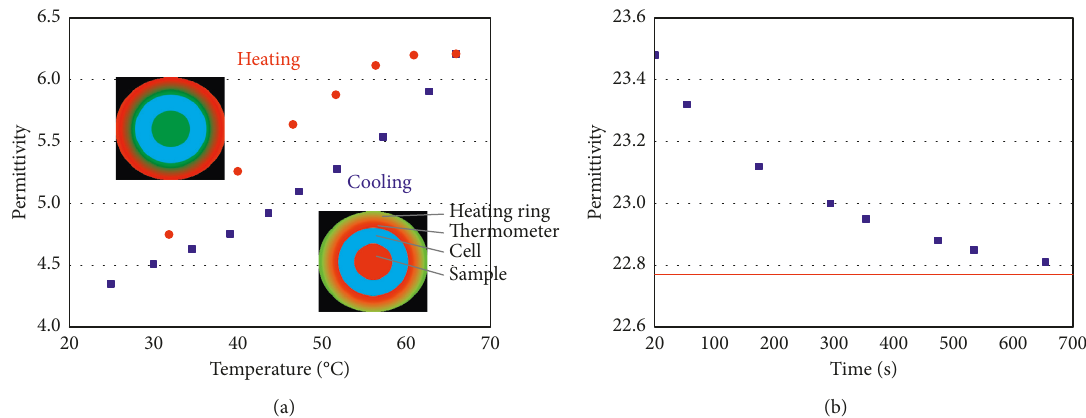
Figure 5: (a) Graphic representing the real part of permittivity of a sample of octanol with a positive and negative slope of temperature variation. (b) Graphic representing the real part of permittivity of ethanol at 100MHz as a function of time. It shows a heating-up process where at the beginning, the temperature was 30 ° C and after 600s, 35 °